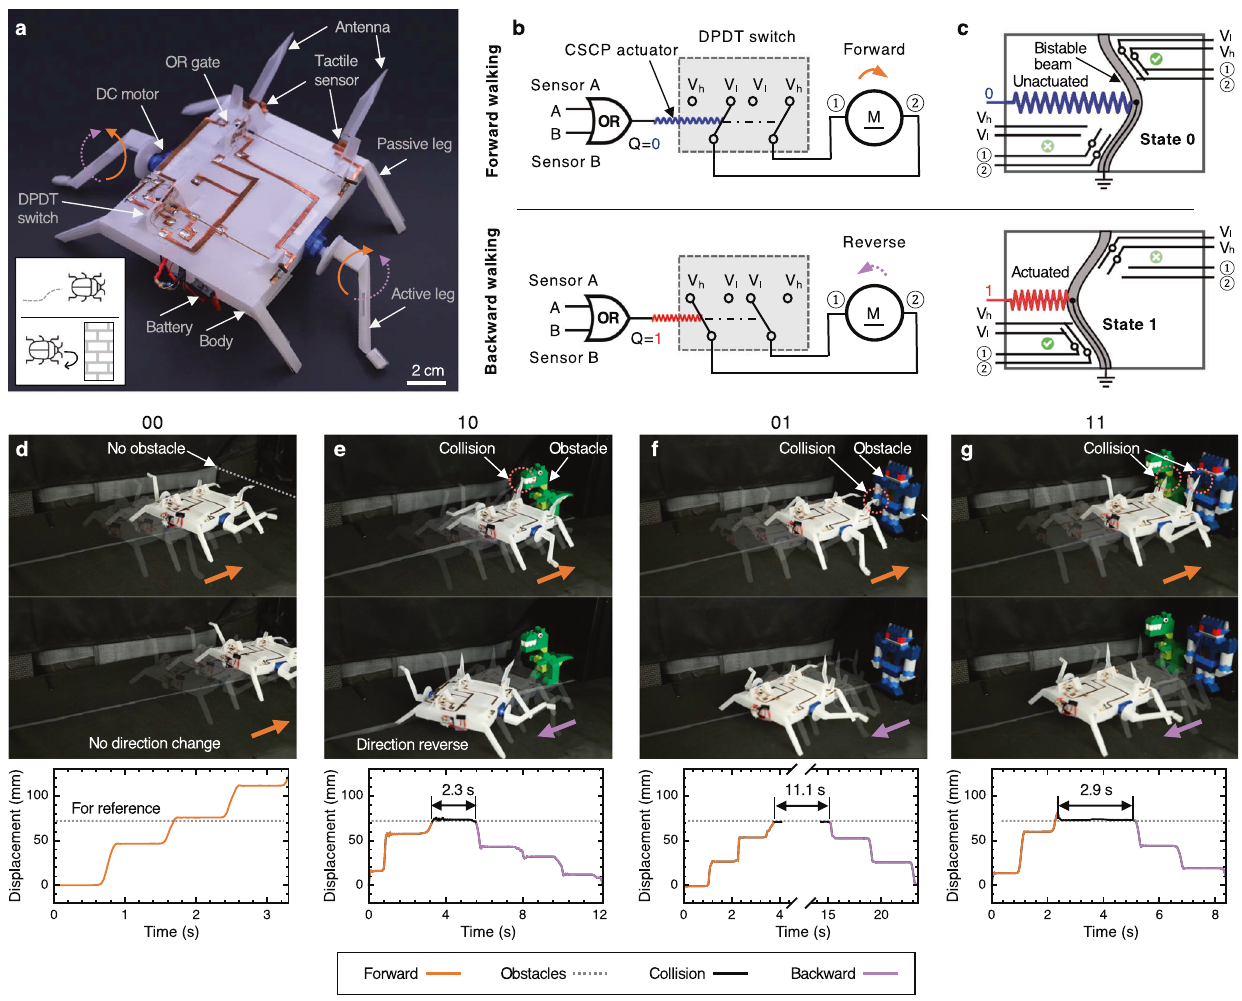
Fig. 6 | The cockroach-inspired self-reversing legged robot. a The detailed structure of the legged robot with labels. b The simpli fi ed circuit diagram of the legged robot.Theinformationfromthetwotactilesensorsonantennadecidesthe output of the origami OR gate; the output of the gate is used to determine the actuation of the CSCP actuator, which could potentially change the rotation direction of DC motors through a DPDT switch. c The schematic of an origami